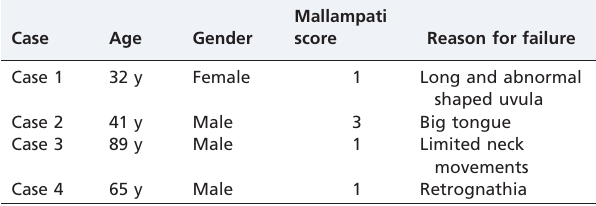
Table 2 - Intubation failures.